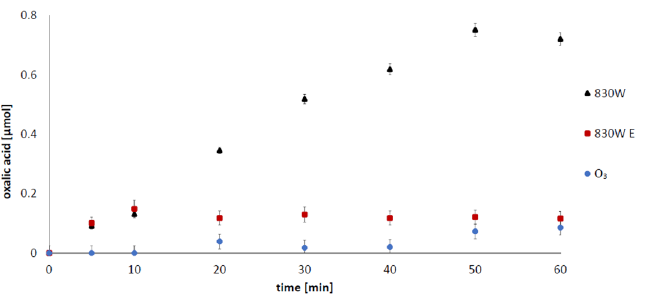
Figure 3. Impact of 830 W carbon impurities on oxalic acid formation at pH 2.5 (2 g/200 ml), 830 W— unpurified carbon; 830 W E—purified carbon, O 3 —ozonation without activated carbon addition. Initial succinic acid concentration 1